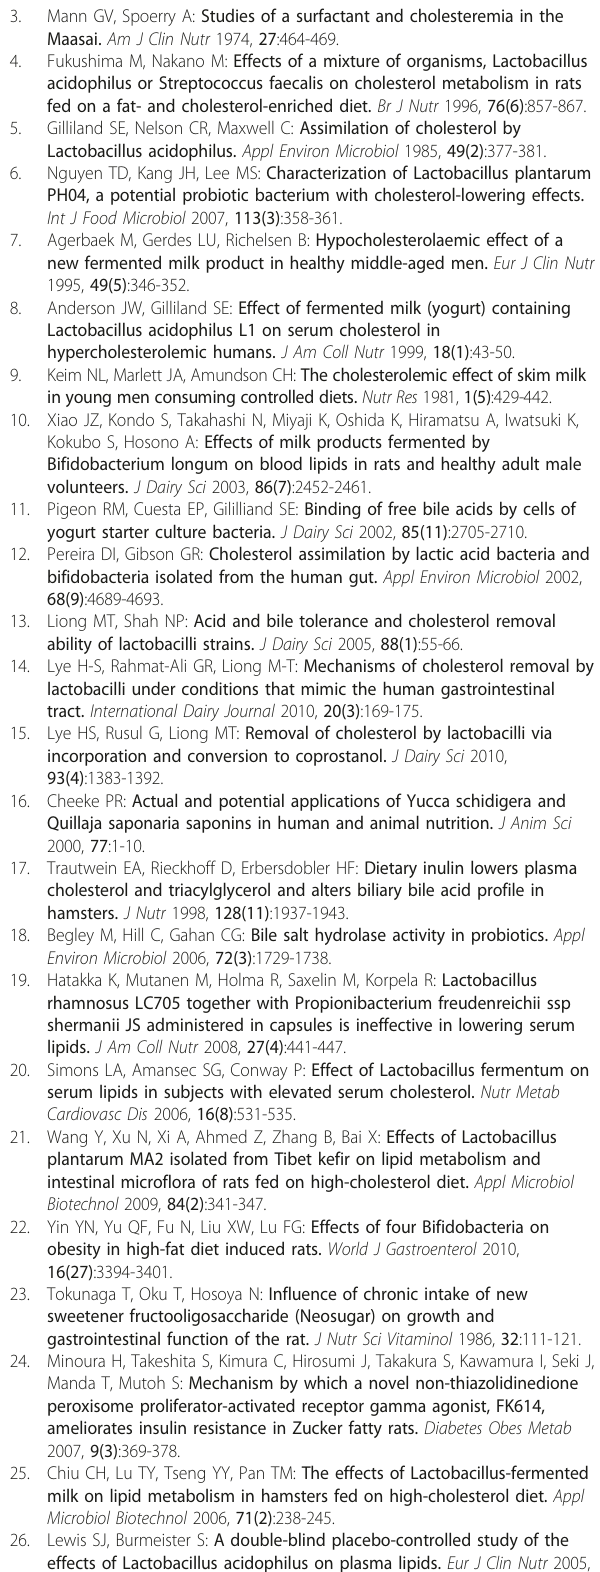
List of abbreviations LAB: Lactic acid bacteria; L .9-41-A: Lactobacillus plantarum 9-41-A; L .M1-16: Lactobacillus fermentum M1-16; E. coli: Escherichia coli ; CVD: cardiovascular diseases; WHO: World Health Organization; CFU: Colony-Forming Units;